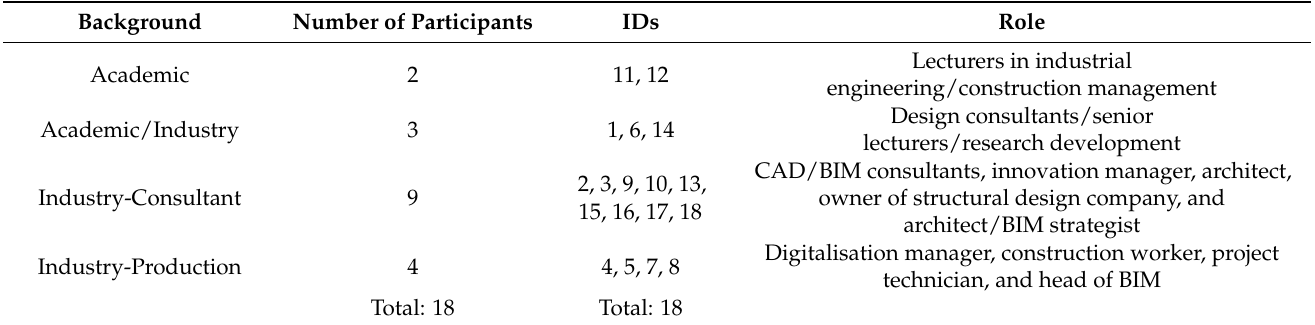
Table 3. Descriptive data of